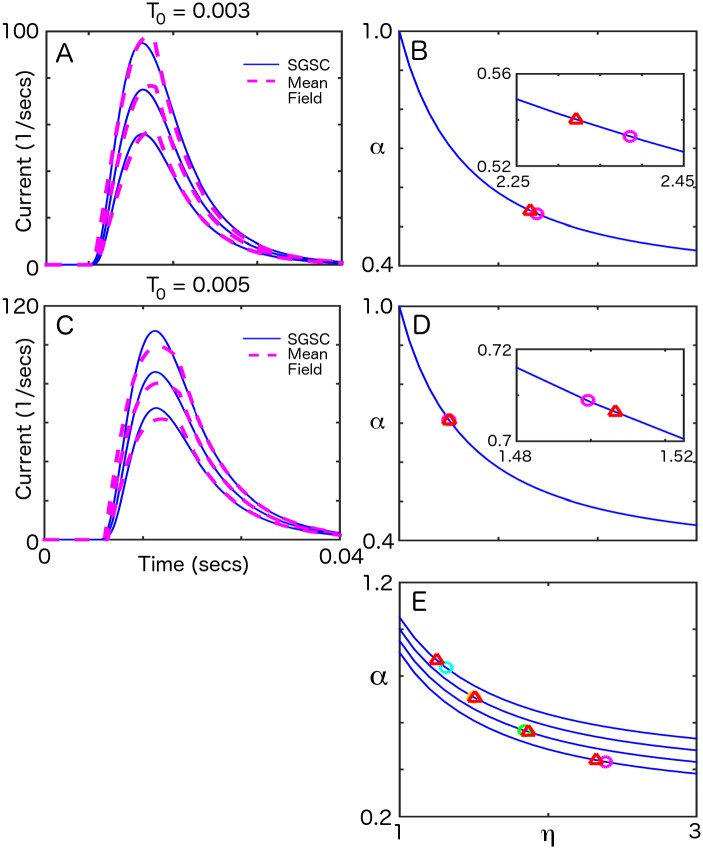
Fitting a square-pulse gated mean-field model of the SGSC.A) Fits of synaptic input currents predicted by the mean-field model to results of I & F simulations for 3 amplitudes for T0 = 0.003. B) T0 = 0.003: Blue line—αexact as a function of η. Red triangle—(ηsim, αsim), purple circle—(ηfit, αfit). Inset: magnification showing location of results from fit. C) Fits of mean-field model and I & F simulation currents for 3 amplitudes for T0 = 0.005. D) T0 = 0.005: Blue line—αexact as a function of η. Red triangle—(ηsim, αsim), purple circle—(ηfit, αfit). Inset: magnification showing location of results from fit. E) Results of fit for T0 = 0.003, 0.004, 0.005, 0.006. Traces offset for clarity.